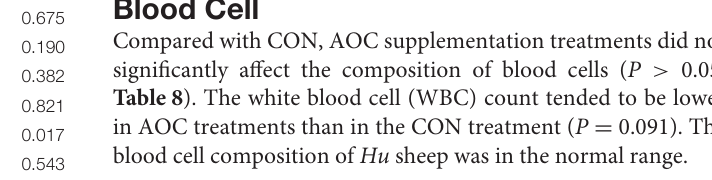
Table 8 ). The white blood cell (WBC) count tended to be lower in AOC treatments than in the CON treatment ( P = 0.091). The blood cell composition of Hu sheep was in the normal